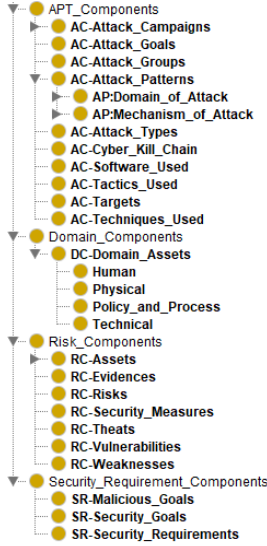
Figure 3. Components of CB-PDO.